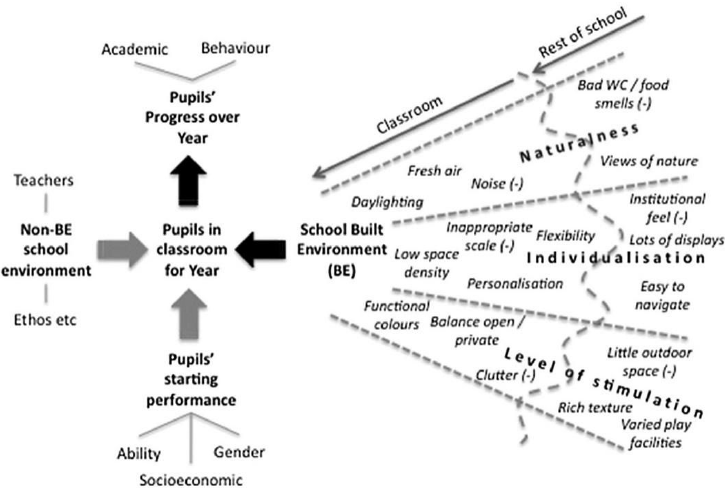
Fig. 1 Environmental art teaching system